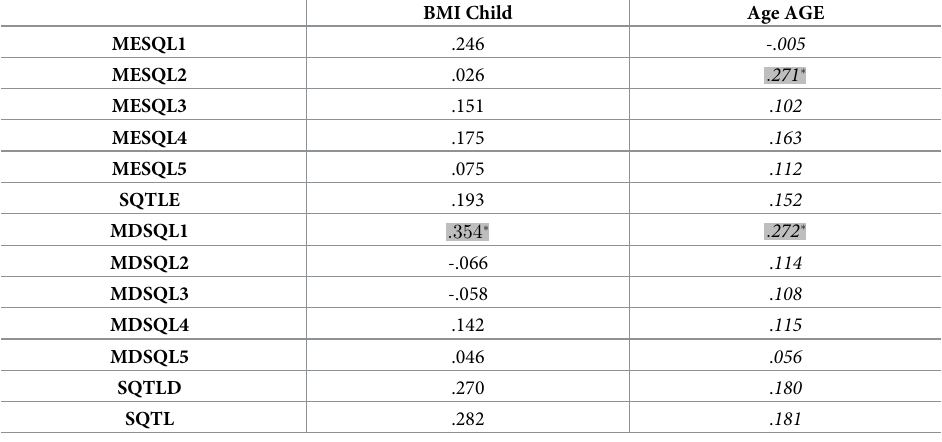
Table present values of Spearman correlation coefficient. � Significant at level of p < 0.05.